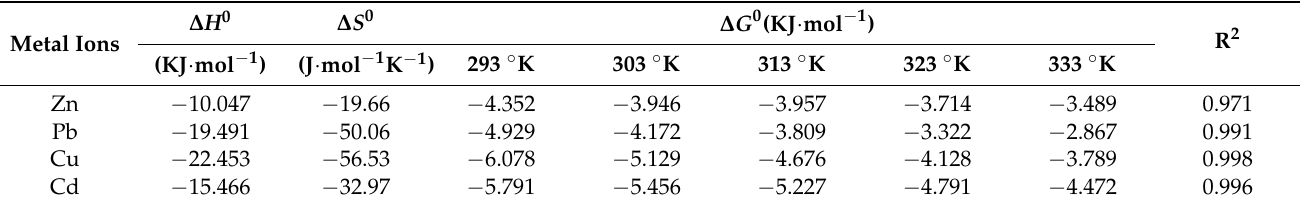
Table 6. Values of thermodynamic parameters for Zn 2+ , Pb 2+ , Cu 2 + and Cd 2+ adsorption upon the synthesized